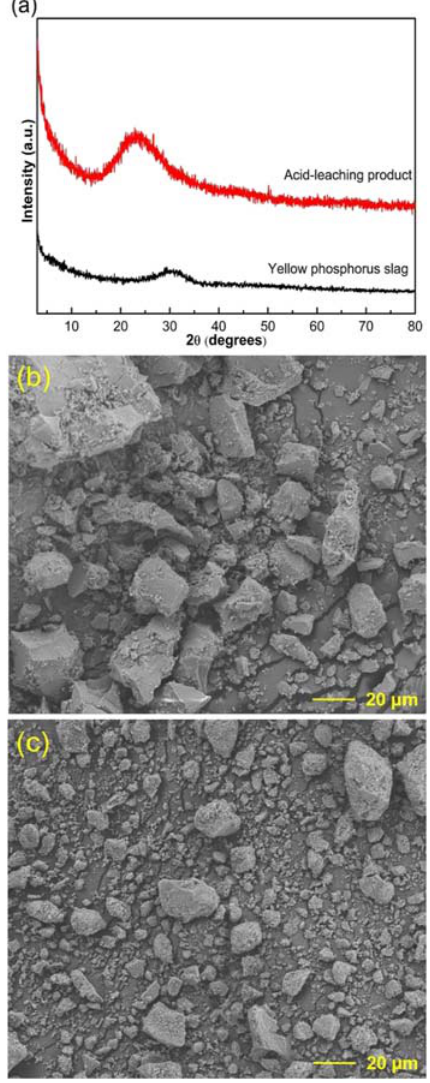
Figure 1: ( a ) XRD patterns and ( b and c ) SEM images of yellow phosphorus slag and acid-leaching